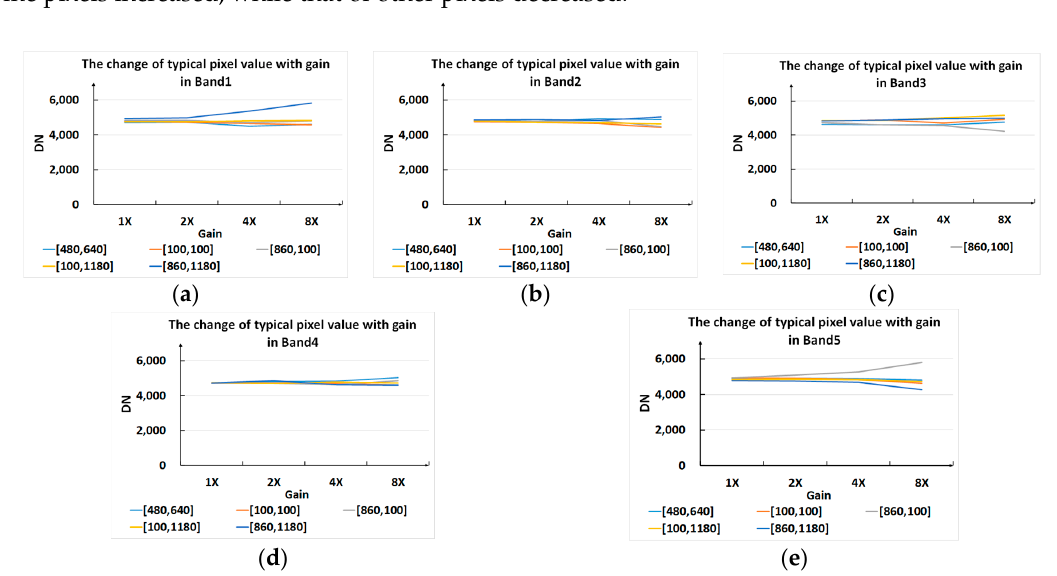
Figure 6. Histograms of dark current images at different gain settings for various bands: ( a ) Band1; ( b ) Band2; ( c ) Band3; ( d ) Band4; ( e ) Band5.